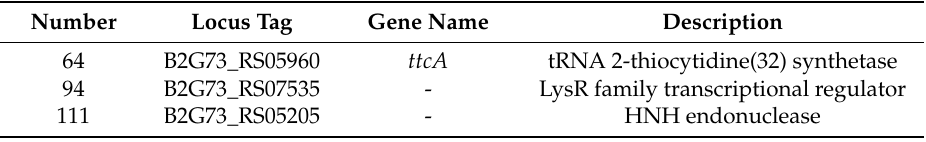
Table 1. Identification of the random insertion sites of Tn5 transposon.